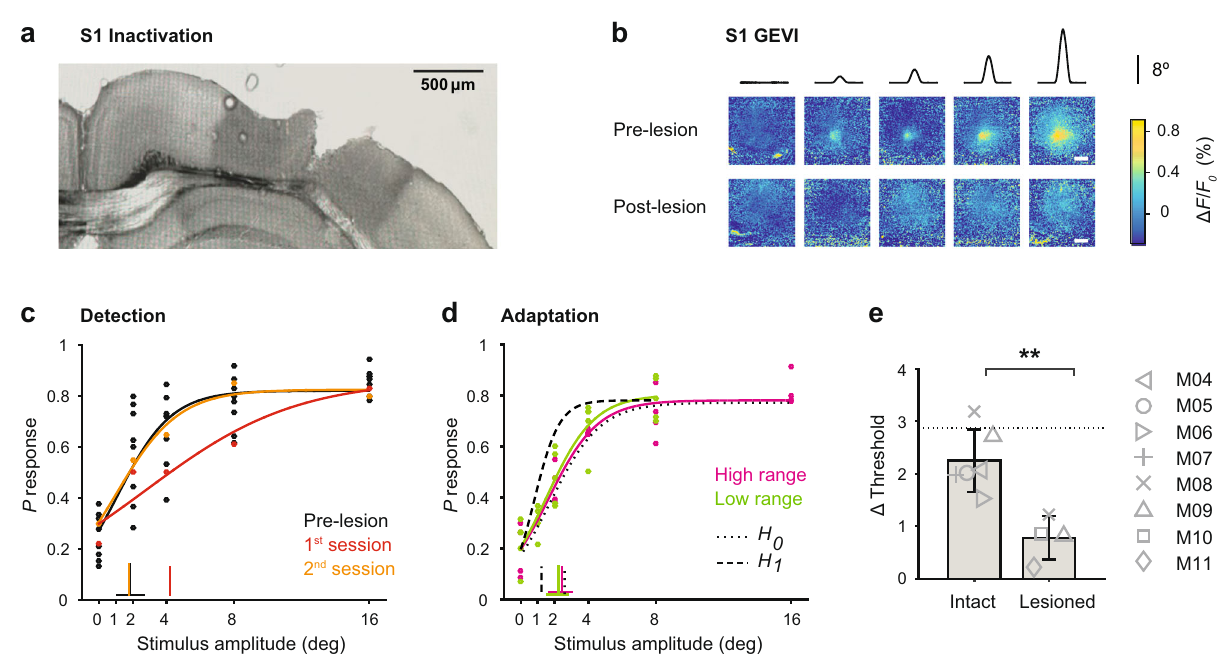
Fig. 6 The effect of S1 inactivation on behavior. a Wide- fi eld image of a coronal mouse brain section (100 μ m, right hemisphere) with cytochrome oxidase staining, showing a S1 lesion upon acid injection (0.3 μ L ibotenic acid 10 mg/mL). b Frames of cortical fl uorescence activity from an example mouse before and after the lesion. Top. Example session with S1 intact, showing GEVI activity patterns in response to different stimulus amplitudes (high range, n = 25 trials per stimulus). Bottom. Example session of the same mouse after the lesion ( n = 18 trials per stimulus). The GEVI activity pattern was used for targeted acid injections. c Psychometric curves and response thresholds for an example mouse detecting high range stimuli before and after the lesion. Each dot corresponds to response probabilities from a single session. Solid curves are logistic fi ts. Note: Pre-lesion data is shown for several sessions ( n = 5) whereas the post-lesion data are shown separately for the fi rst (red) and second session (orange) upon lesion. d Psychometric curves and response thresholds for the same mouse challenged with a change in stimulus statistics (high range to low range) upon S1 inactivation. Solid curves are logistic fi ts to the average data ( n = 4 – 5 sessions). Otherwise, fi gure conventions are the same as in Fig. 3. e Behavioral adaptation is calculated as the change in psychometric threshold ( Δ threshold) for healthy and lesioned animals. Bars represent means across mice with SD ( n = 6 intact, n = 4 lesioned). The dotted line represents the mean across sham-operated mice ( n = 2). ** P = 0.01, two-sided Wilcoxon rank-sum